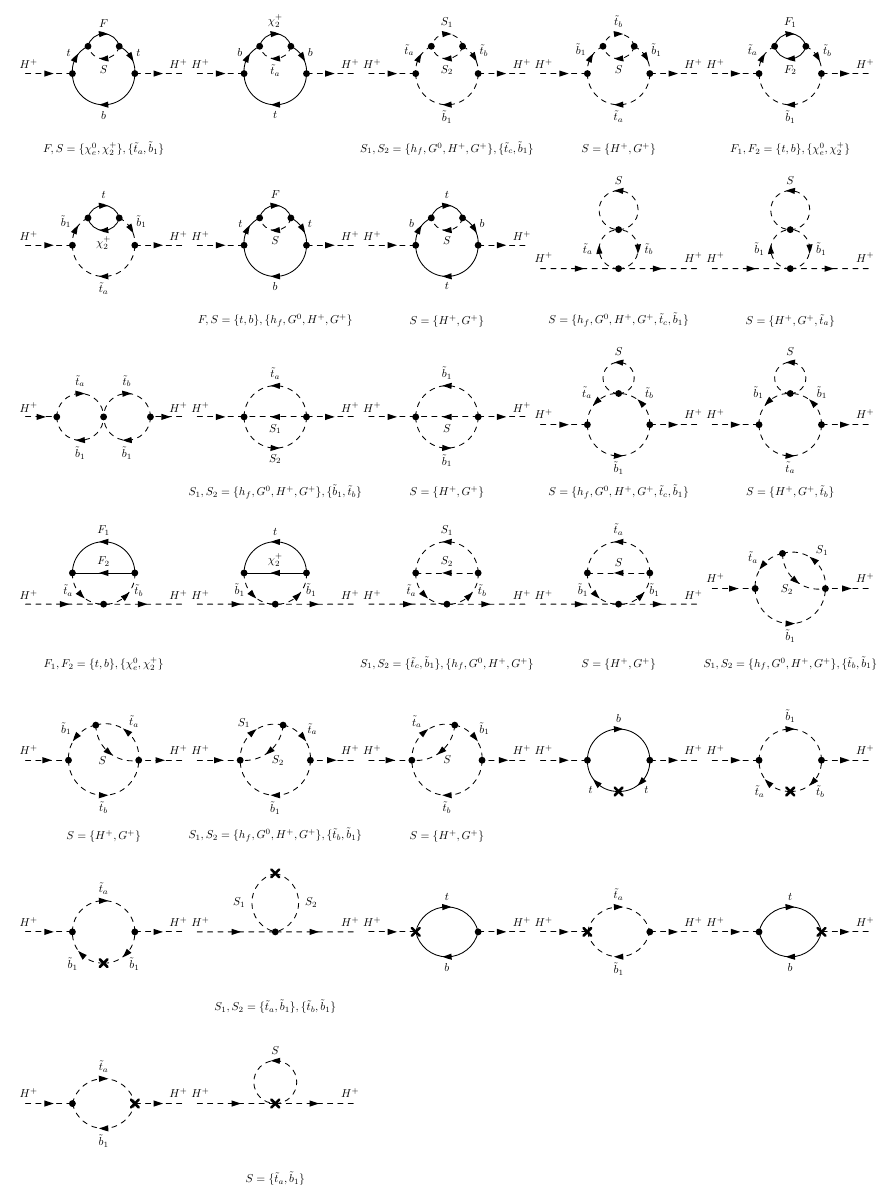
Figure 15 . Generic two-loop self-energies of the charged Higgs boson contributing to the compu- tation of the two-loop counterterm of the charged Higgs boson mass. The placeholders S i and F i ( i = 1 ; 2) stand for the particle content of the diagrams speci(cid:12)ed below the respective diagrams. Diagrams with a cross denote the insertion of the respective one-loop counterterms of the vertices and masses. A summation over all internal particles with indices a; b; c; d = 1 ; 2, e = 3 ; 4 ; 5 and f = 1 ; : : : ; 5 is implicit. Note that additional diagrams that di(cid:11)er from the ones shown only by the inversion of the fermion current are not explicitly shown.